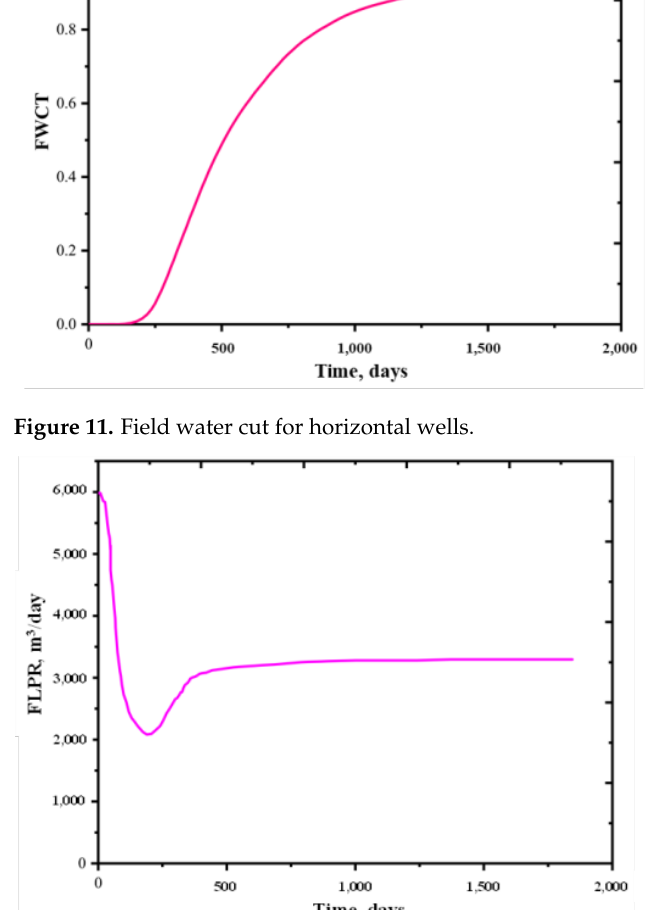
Figure 11. Field water cut for horizontal wells.